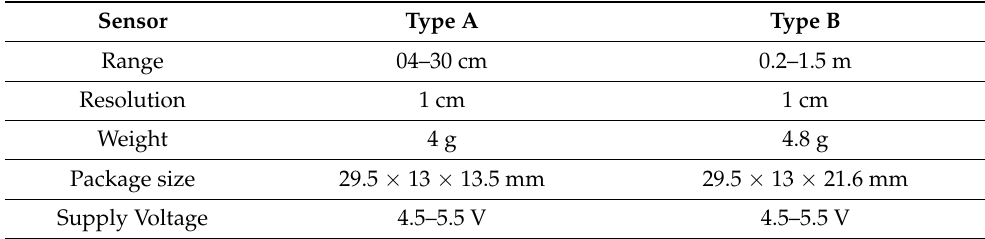
Table 2. Sensor manufacturer specifications